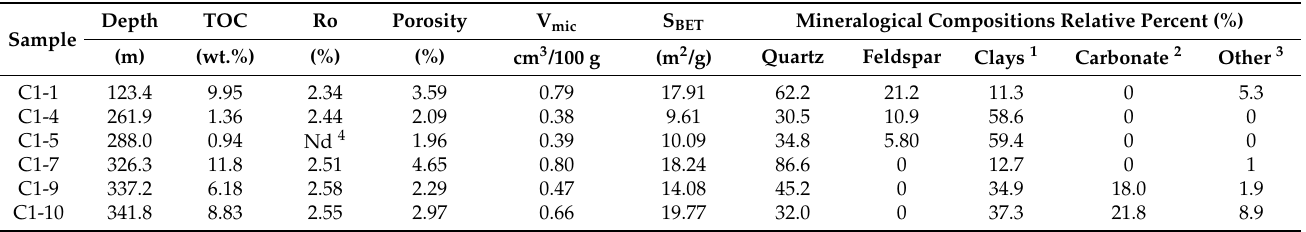
Table 1. Geochemistry parameters, mineralogical compositions and pore structure characteristics of the Permian samples (data from Pan et al.